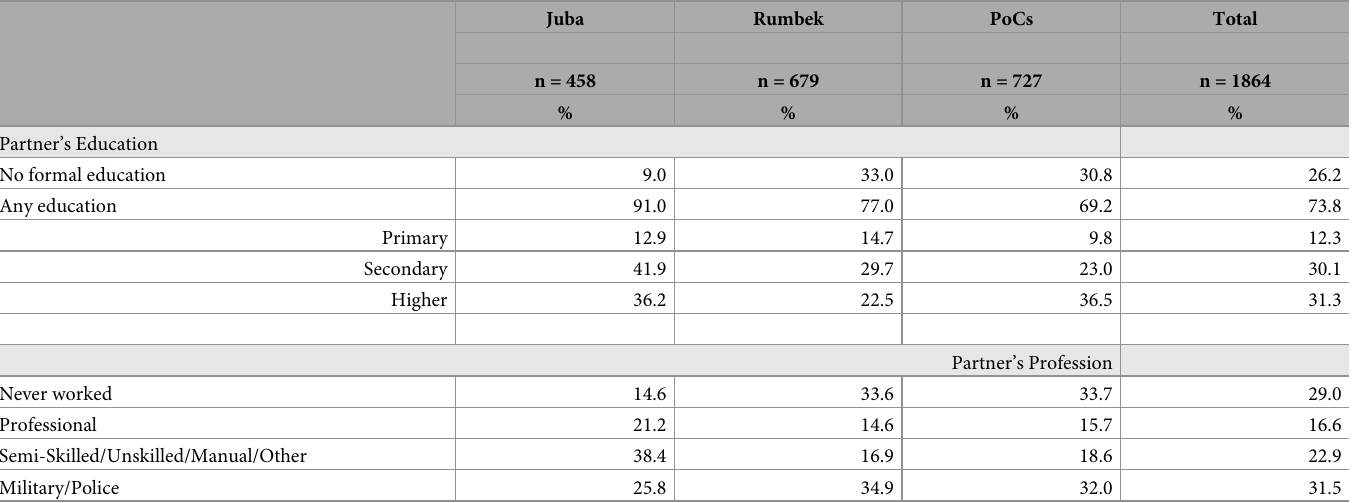
Table 2. Partners’